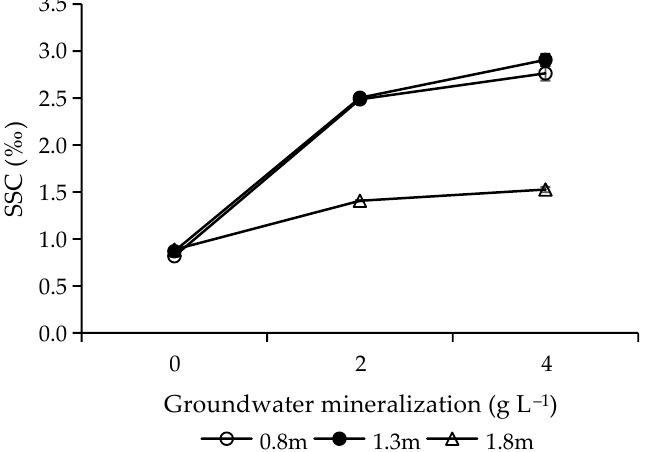
Figure 3. Effects of groundwater mineralization and groundwater depth on soil salt content. Error bars indicate standard errors (SEs) of the mean.